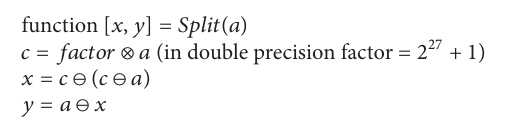
Algorithm 2: Split of a floating point number into two parts.